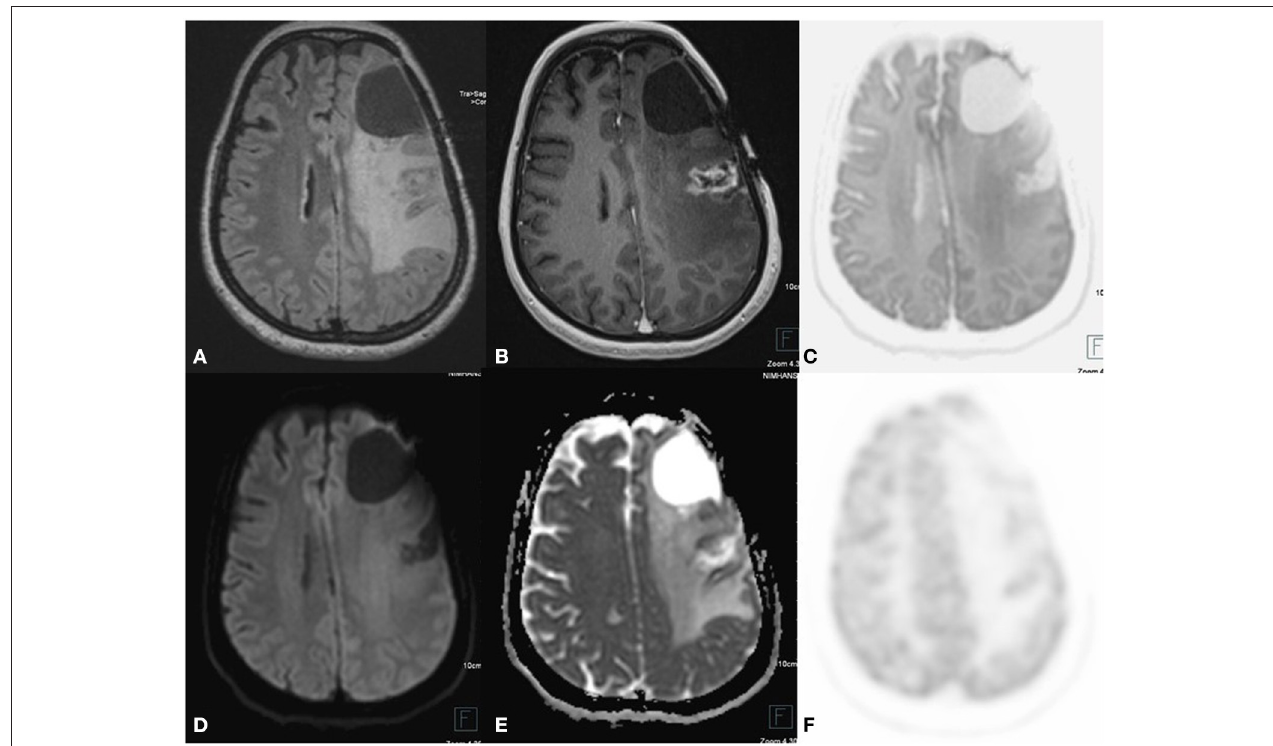
FIGURE 2 | A 24 year old female postoperative, post-RT case of Glioma left frontal lobe, 3 year follow up MRI FDG PET axial images T2-FLAIR (A) post-contrast T1 (B) Inverted DWI (C) DWI b2000 (D) ADC (E) NAC PET (F) show a postoperative cavity in the left frontal lobe with Swiss cheese-like enhancing lesion posterior to postoperative either no elevated perfusion. Neither DWI restriction nor elevated metabolism on PET is seen, which is suggestive of radiation necrosis.